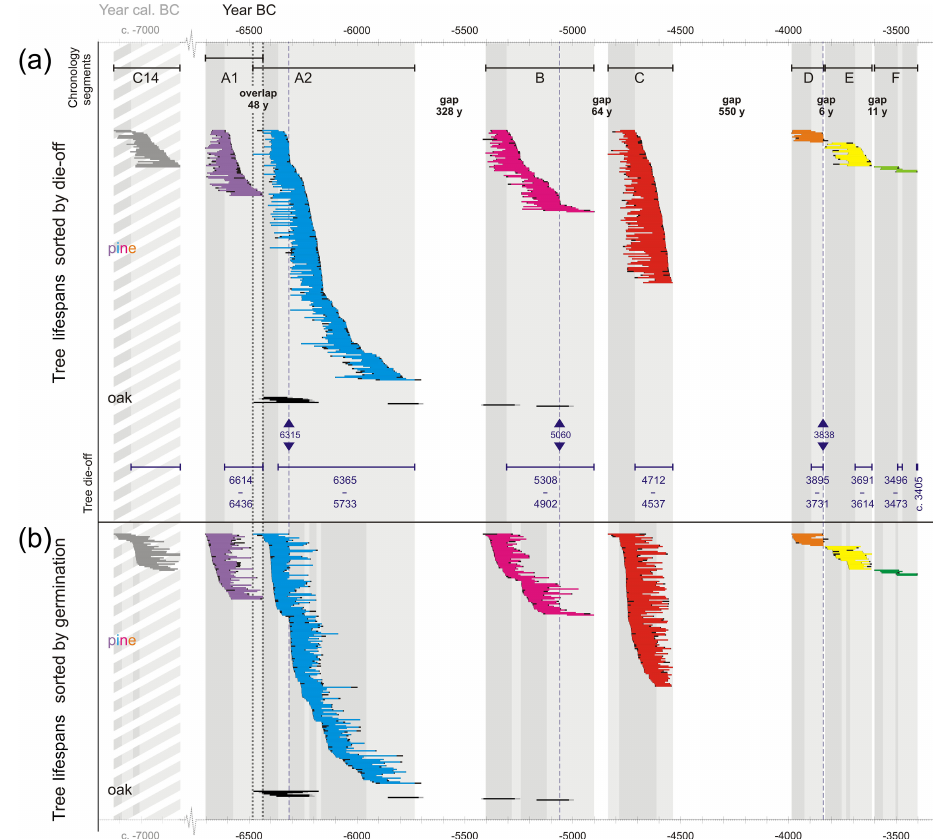
Figure 4. Temporal distribution of pine trees at site TOMO_south. On top the chronology segments C14 and A1-F are indicated. The gaps between the site chronology segments (white) are labelled with their duration. The time covered by the site chronologies of TOMO_south is underlain in grey, and that for the floating chronology segment C14 striped in grey-white. The coloured horizontal lines indicate the lifespans of the individual dated trees from the site (measured rings coloured, estimated missing rings black). The trees of each chronology segment (Table 1) are shown in a different colour (A1: dark violet; A2: blue; B: pink; C: red; D: orange; E: yellow; F: green), the floating chronology segment C14 in grey. The colours are used accordingly in the spatial mapping (Figs. 5 and 6). The oaks from the site are displayed in black, below the pines. In (a) the trees are sorted by dying-off date. The three most prominent events of cumulative tree dying-off are highlighted by a dashed blue vertical line and labelled by year BC. Below, the periods from first to last tree dying-off (last measured ring) are indicated, labelled by years BC. The lighter grey backgrounds indicate when the trees of a chronology segment start to die off. In (b) the trees are sorted by germination date. Here, the lighter grey backgrounds indicate periods with limited tree